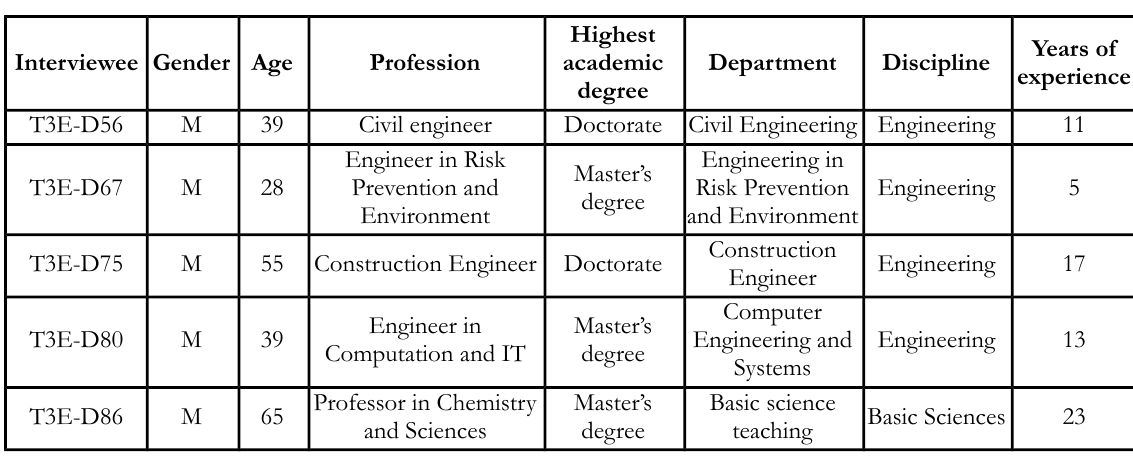
Table 2. Detailed description of the 10 case